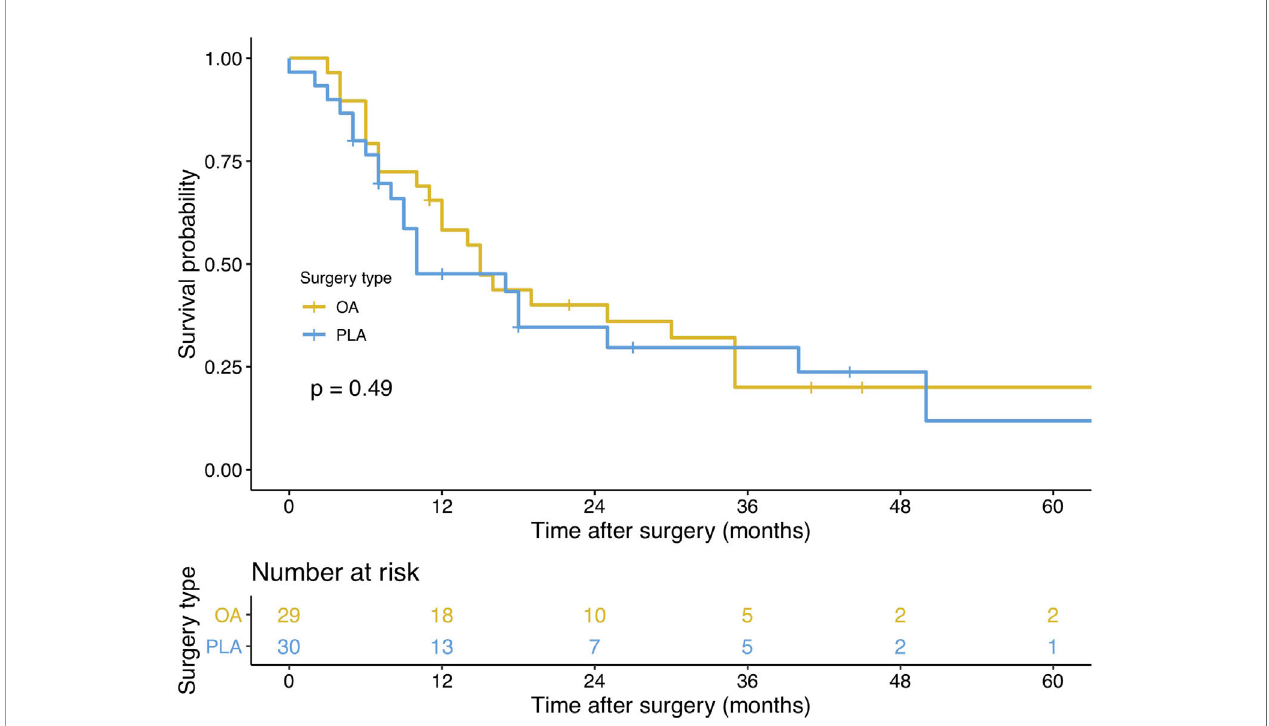
FIGURE 4 | A comparison of disease-free survival of primary outcomes after OA or PLA in GBC patients. OA, open approach; PLA, primary laparoscopic approach; GBC, gallbladder cancer.